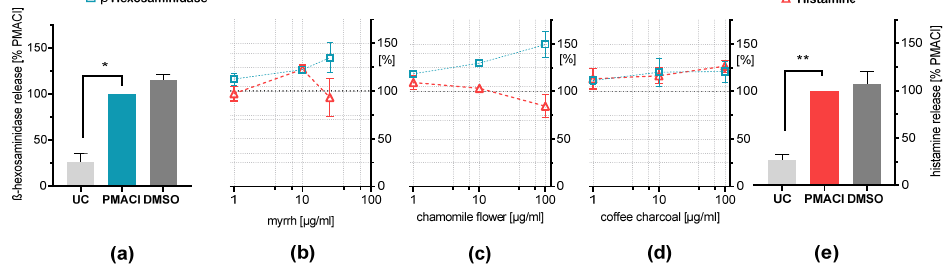
Figure 2. Effects of the plant extracts on mediator release of PMA and CI stimulated RBL-2H3 cells. β -hexosaminidase ( □ ) and histamine ( ∆ ) release were determined after 30 min stimulation with 40 nM PMA + 1 µM CI (PMACI = 100%) compared untreated control (UC) and vehicle control (PMACI + 0.2% DMSO) ( a , e ). ( b ) Myrrh resin extract (1–50 µg/mL), ( c ) chamomile flower extract (1–200 µg/mL), or ( d ) coffee charcoal extract (1–200 µg/mL) were incubated overnight (18 h) before PMACI stimulation. Results are presented as means ± SEM. n = 3; * p < 0.05; ** p < 0.01.